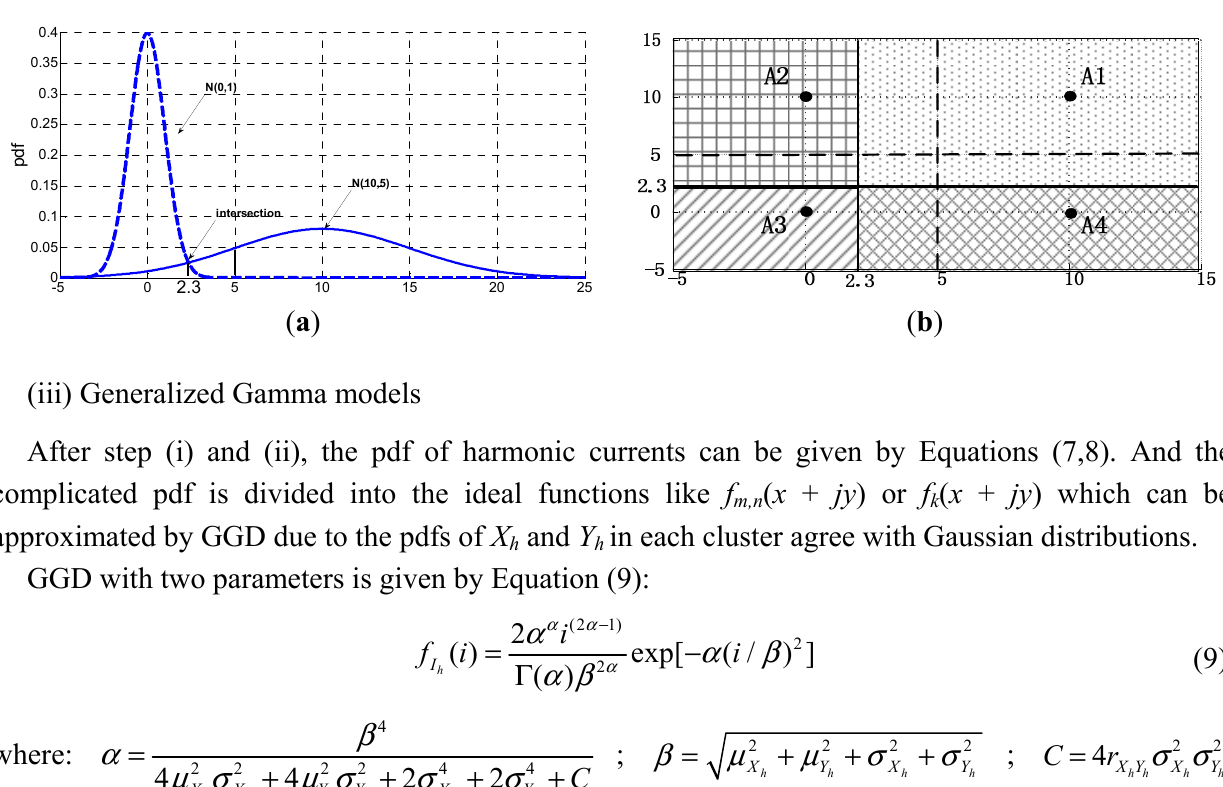
Figure 4. Verification of the optimal phasor clustering. ( a ) Pdf and division axis of X component; ( b ) Comparison of two clustering